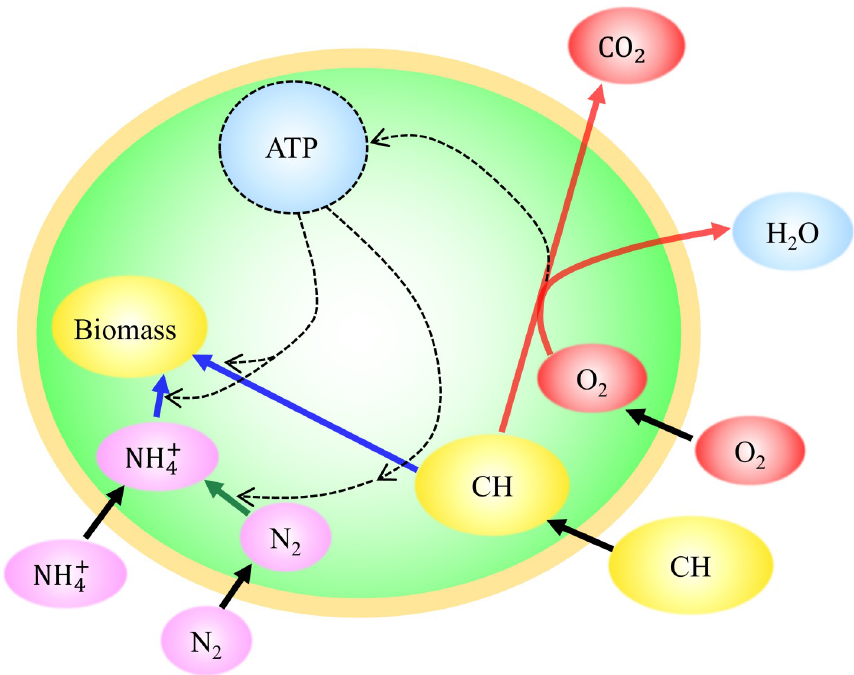
Fig 2. The cell flux model of a nitrogen fixing cell with ammonium uptake included. Solid black arrows, nutrient uptake; dashed black arrows, energy flow; red arrows, respiration; blue arrows, biomass production; green arrow, nitrogen fixation. CH represents carbohydrate. The competing nitrogen sources are computed based on maximizing biomass concentration.